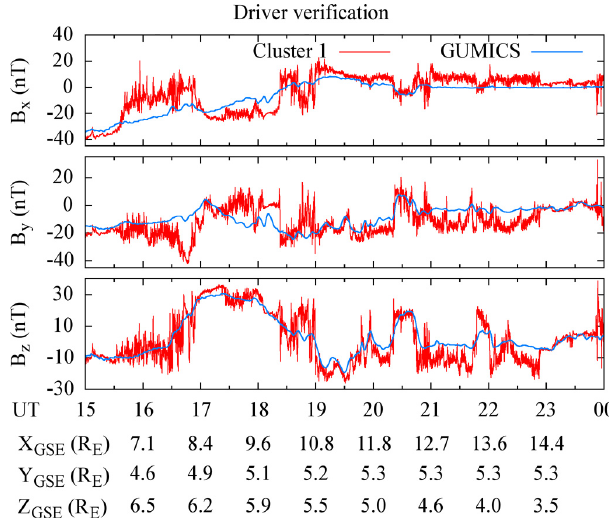
Fig. 5. The magnetic field from Cluster 1 and the simulation at the same location as function of